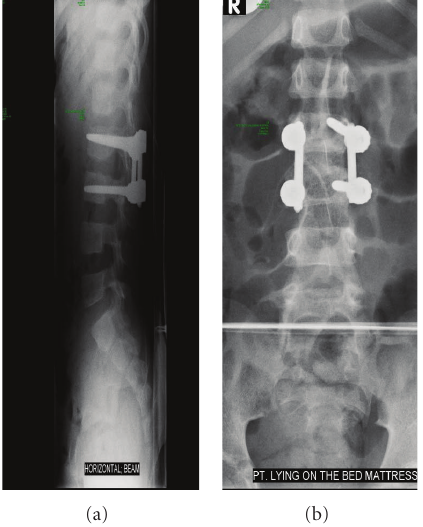
Figure 2: Lateral (a) and anteroposterior (b) radiographs of the lumbar spine after decompression of the spinal cord and fusion of second and third vertebral bodies